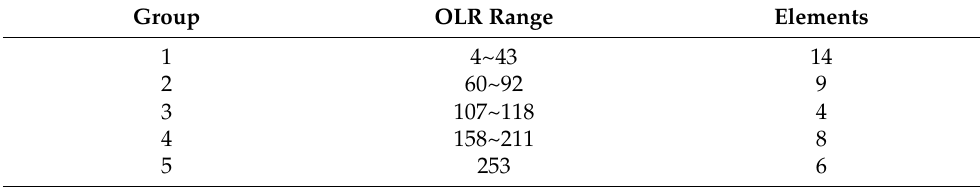
Table 1. Cluster analysis results, OLR range and the number of elements in each group. Group